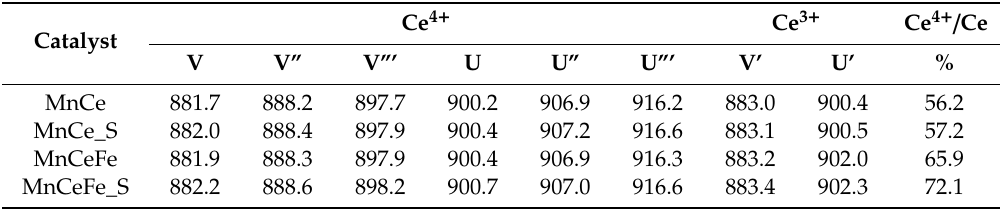
Table 4. Ce 3d XPS parameters of MnCe, MnCe_S, MnCeFe and MnCeFe_S.